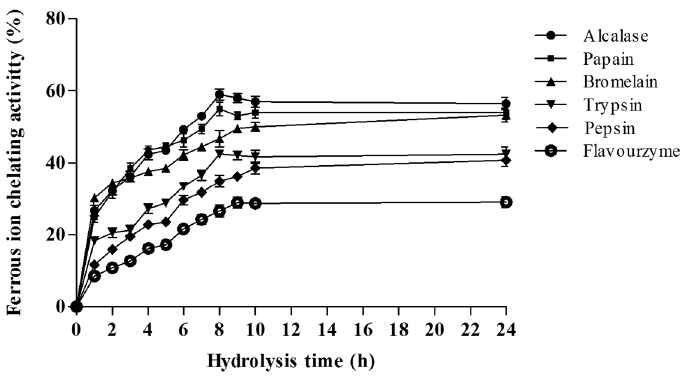
Figure 5. Effect of hydrolysis time on the ferrous ion chelating activity (FIC) (%) of A. lecanora hydrolysates generated from enzymatic digestion for 24 h. Sample concentration for this assay was 1.0 mg dry weight/mL. Each value is the mean ± SD of three replications.